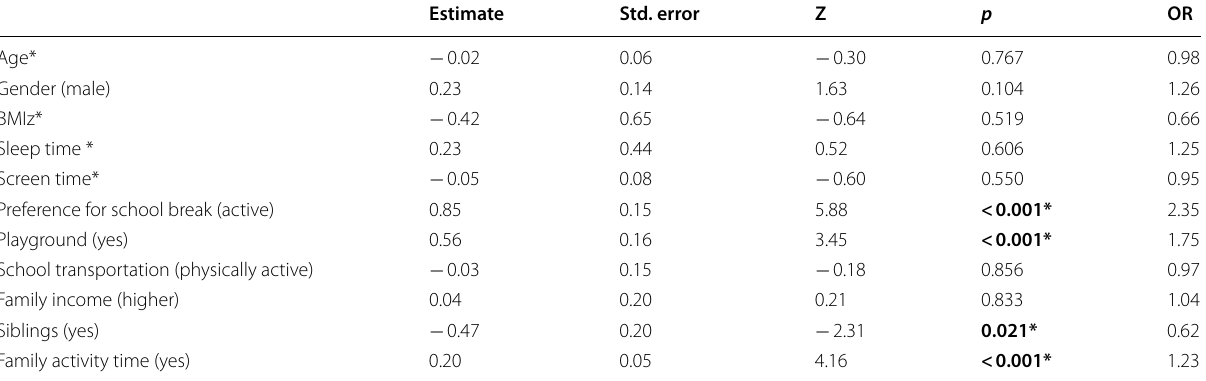
*Continuous variable, AIC: 1248 Goodness of fit